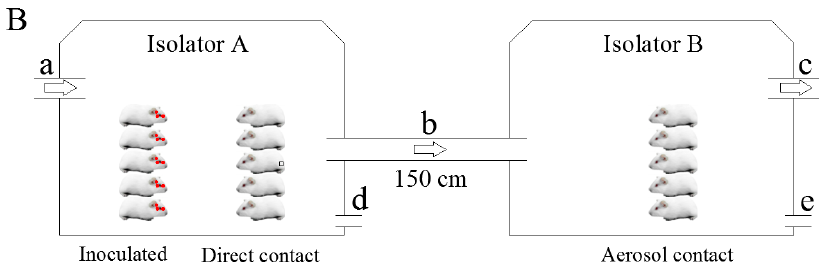
Figure 1. Transmission experiments of SPF chickens and guinea pigs. The experiments were constructed in a biosecurity level 2+ laboratory. ( A ). Ten inoculated SPF chickens and 10 direct contact SPF chickens were placed in the isolator A. Another 10 SPF chickens of aerosol contact were placed in isolator B, which was connected by an air tube with isolator A. ( B ). Five inoculated guinea pigs and five direct contact guinea pigs were placed in the isolator A. Another five guinea pigs of aerosol contact were placed in isolator B, which was connected by an air tube with A. (a) Positive pressure fan with High Efficiency Particle Air (HEPA) filters. (b) The tube connected the isolators and allowed the air flowing from isolator A to isolator B. (c) Negative pressure fan with HEPA filters (d) and (e) sampling holes from which air samples were collected.